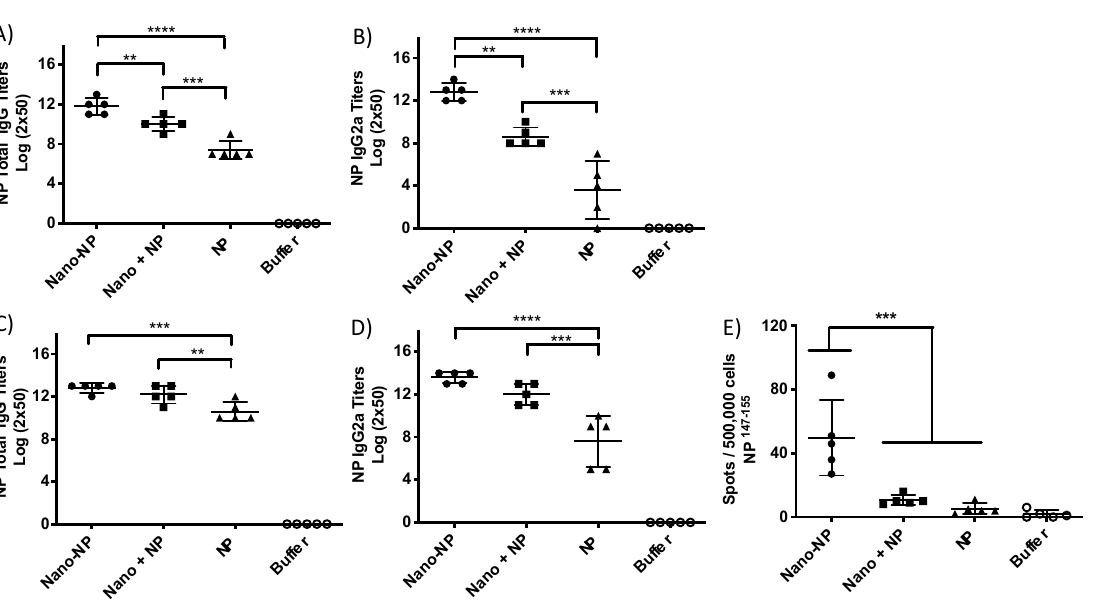
Figure 3. Coupling of NP to PapMV nanoparticle enhances the immune response directed to the NP antigen. Balb/C mice, 5 per group, were immunized twice i.m. at a 14 day interval with PapMV nano coupled to the NP antigen (nano-NP) (90 µg), PapMV nano (90 µg) mixed with NP (9 µg) (Nano plus NP), NP alone (9 µg) and buffer control (PBS 1X). The assessment of the humoral response directed to the NP recombinant antigen was performed with serum harvested at day 13 ( A , B ) and at day 28 ( C and D ). The anti-NP total IgG ( A,C ) or the anti-NP IgG2a titers ( B , D ) were measured. The spleen was harvested at day 28 to perform the ELISPOT assay ( E ). The splenocytes were activated with the CTL epitope NP 147-155 . ** p < 0.01, *** p < 0.001, **** p < 0.0001.